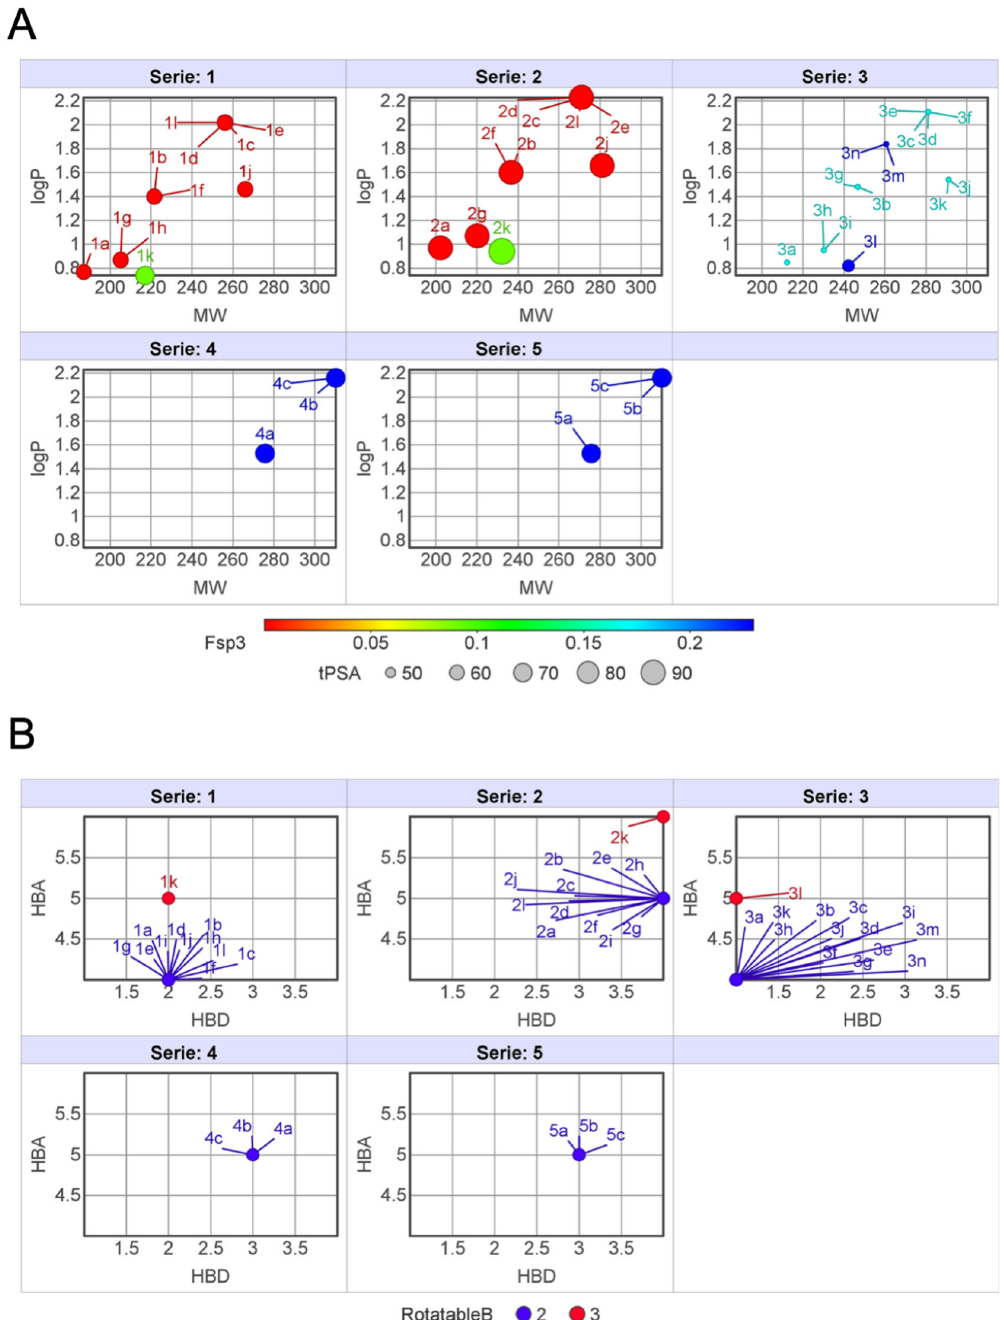
Figure 2. Physicochemical properties of pyrazole derivatives, 1 ( a – l ), 2 ( a – l ), 3 ( a – n ), 4 ( a – c ) and 5 ( a – c ), were calculated using DataWarrior software. ( A ) Classification of compounds according to the lipophilicity (LogP), molecular weight (MW), the fraction of sp 3 carbon atoms (Fsp 3 ; color scale) and the topological polar surface area (tPSA; label size). ( B ) Distribution graph of compounds based on number of hydrogen bond donors (HBD) and acceptors (HBA), and rotatable bonds (Rotatable B; colored circles).